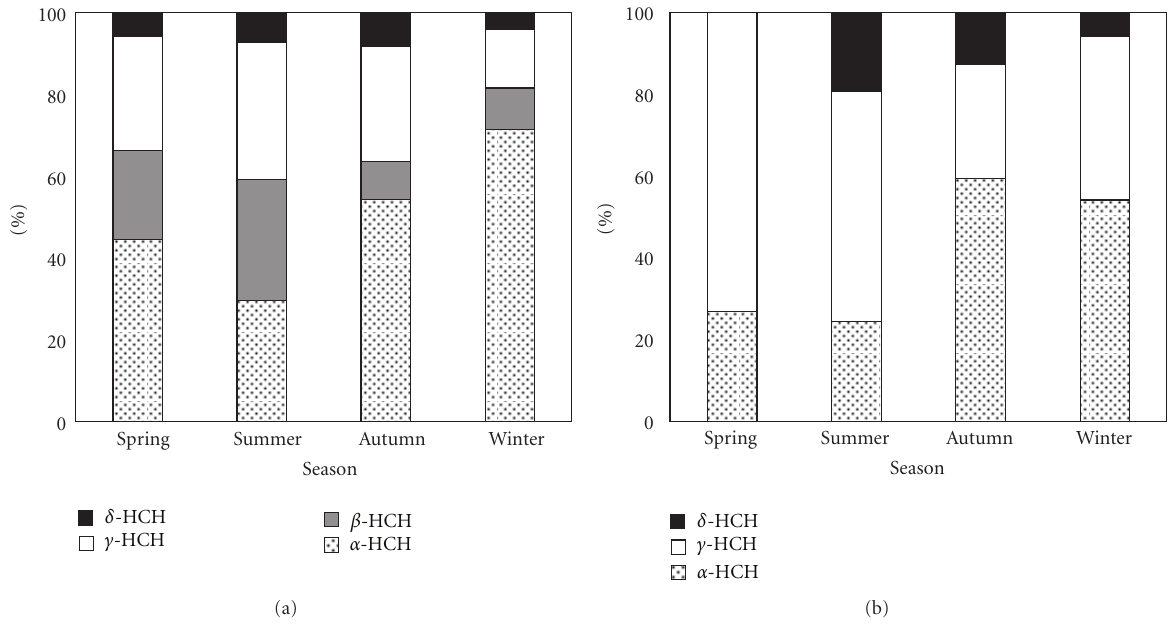
Figure 3: Seasonal variations of HCHs in the gas phase (a) and particle phase (b) at Lake Chaohu from March 2010 to February 2011.